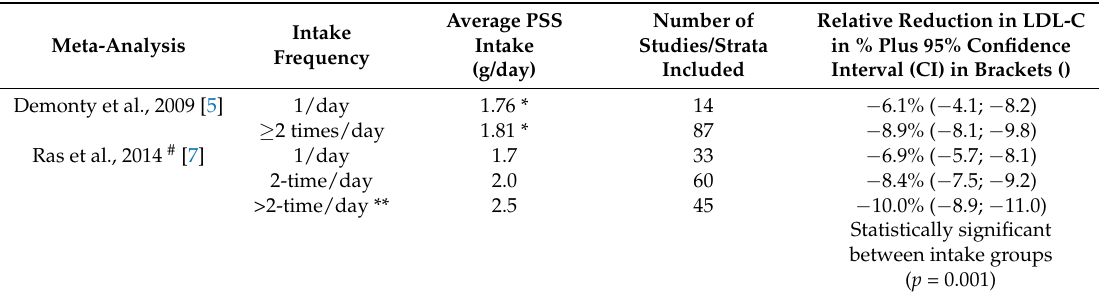
Table 2. Impact of intake frequency on the LDL-cholesterol (LDL-C) lowering effect of plant sterols and stanols (combined as PSS) as described in two